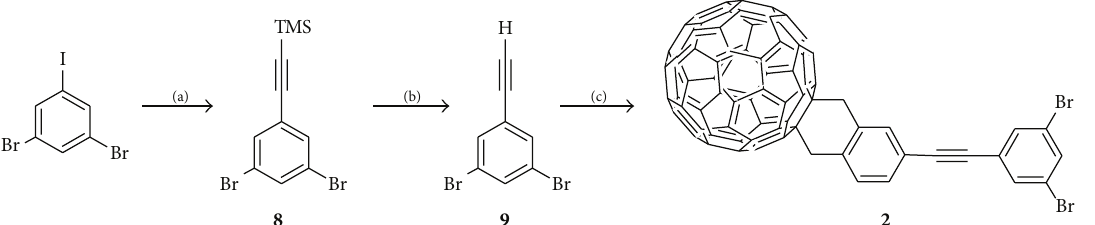
Scheme 2: Synthesis of polymer repeat 2 . Reaction conditions: (a) palladium catalyst, CuI, Et 3 N, toluene, and TMS acetylene; (b) THF, NaOH, and MeOH; (c) palladium catalyst, CuI, Et 3 N, 1 , and toluene.